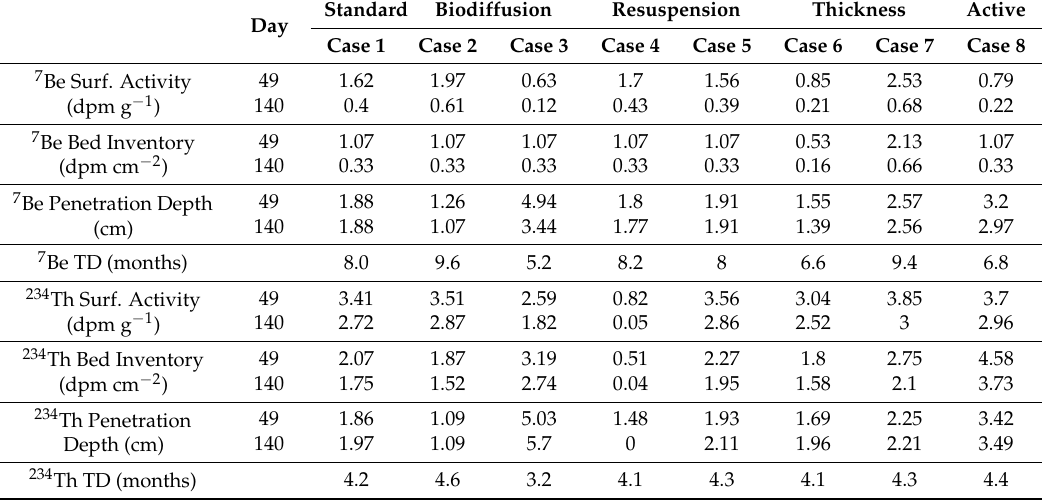
Figure 4. Radioisotope profiles calculated that ( a , b ) used D b,max = 1 cm 2 yr − 1 and had a flood deposit 0.75 cm thick (Case 1), ( c , d ) neglected biodiffusion (Case 2), ( e , f ) used D b,max = 25 cm 2 yr − 1 (Case 3), ( g , h ) had a flood deposit 0.38 cm thick (Case 4), and ( i , j ) had a flood deposit 1.51 cm thick (Case 5). Top row shows results on Day 49 while bottom row shows Day 140. Horizontal lines are as described in Figure 3. The gray box represents the extent of the initial flood deposit, red line denotes depth of resuspended layer, green line denotes the maximum penetration of the active layer when sediment was resuspended. The bed height after initial deposition is defined as z bed = 0. Table 2. Surface activities, bed inventories, penetration depths, and detection timescales after times when no sediment was resuspended, but cover a range of time since initial deposition of 7